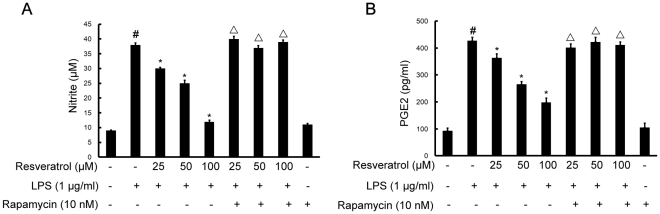
mTOR is required for resveratrol-inhibited expression of NO (A) and PGE2 (B) induced by LPS in BV-2 cells.Approximately 1×106 cells/ml were seeded in six-well plates and incubated until 80% confluency. Cells were pre-treated with resveratrol (25, 50, and 100 µM) for 1 h in the absence or presence of rapamycin (10 nM), then exposed to LPS (1 µg/ml) for 8 h. The values shown are mean ± SEM of data from three independent experiments. #Significant compared with control alone, p<0.05. *Significant compared with LPS alone, p<0.05. ▵Significant compared with resveratrol+LPS, p<0.05.